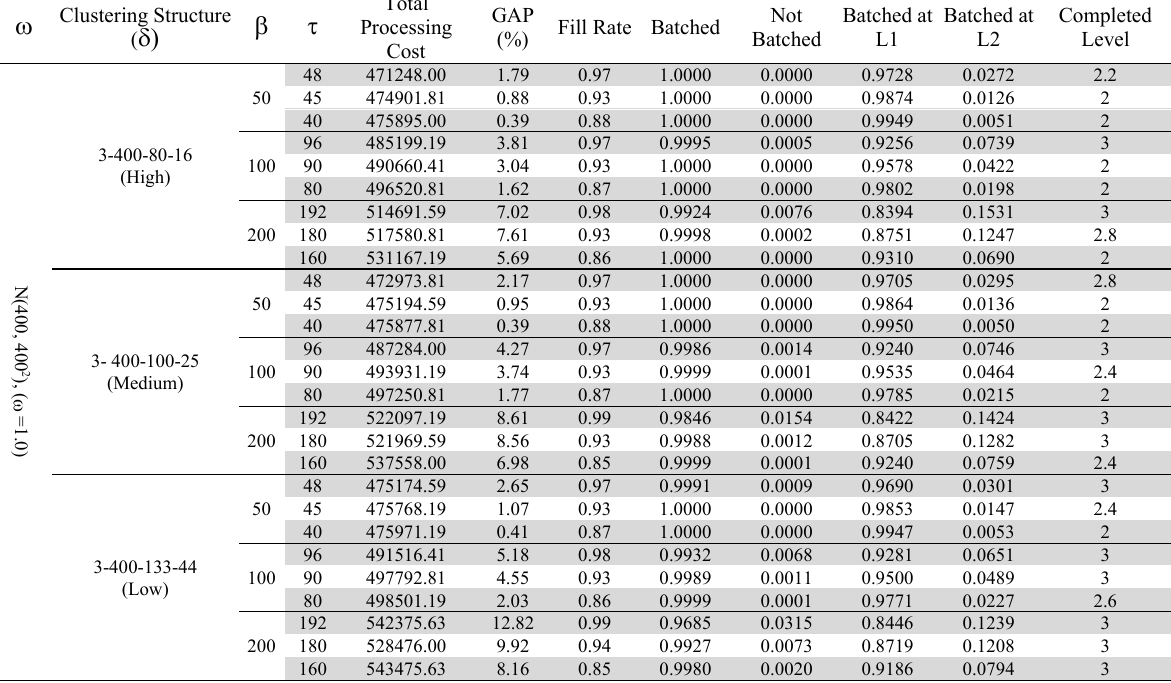
Results for demand scenario S-1 with 3-Level non-exclusive AHCS 